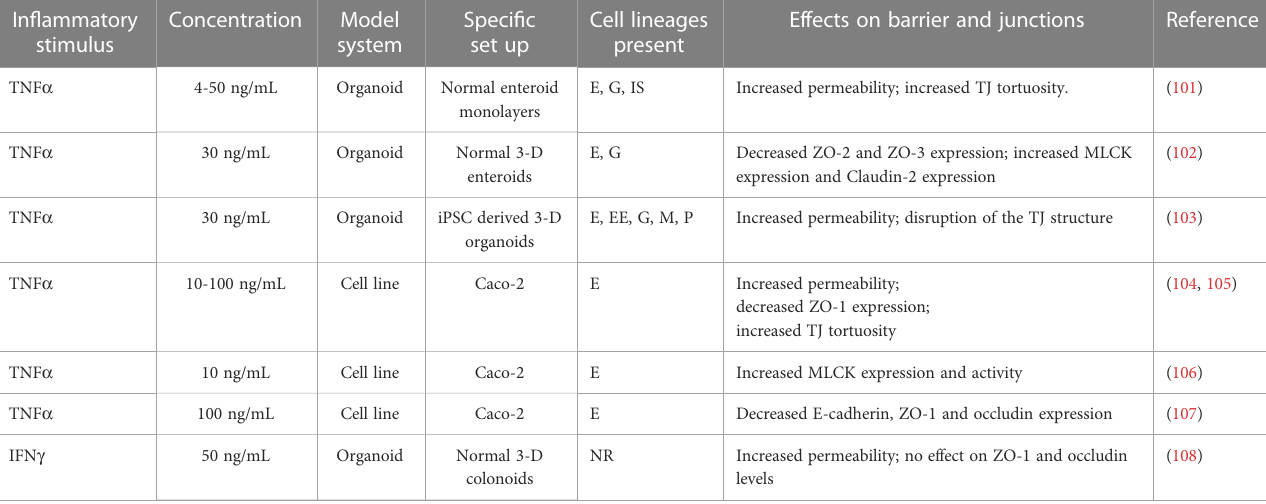
TABLE 1 Effects of in fl ammatory mediators on barrier properties of human intestinal organoids and conventional IEC lines. In fl